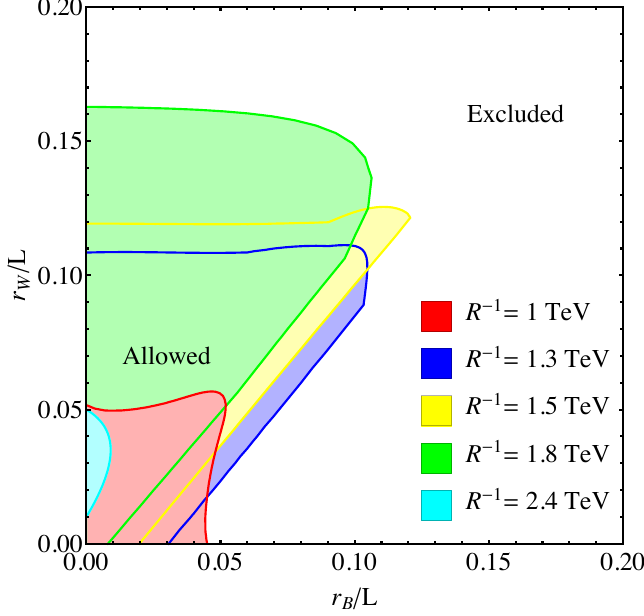
Figure 7 . Combined bounds from dilepton searches for A (2) the Universe by the relic density of the LKP in the r W =L vs. r B =L parameter plane. The shaded regions represent the allowed parameter space for various values of R (cid:0) 1